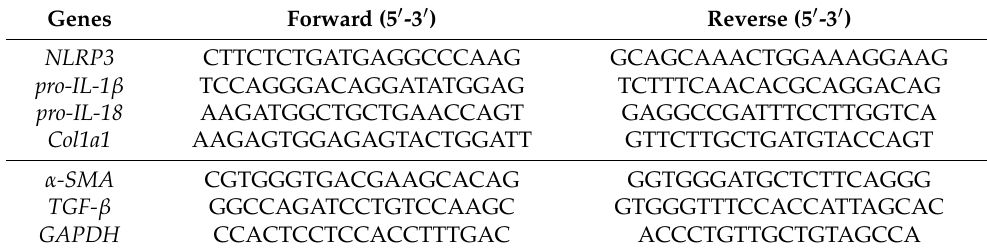
Table 2. Sequence of primers used for quantitative